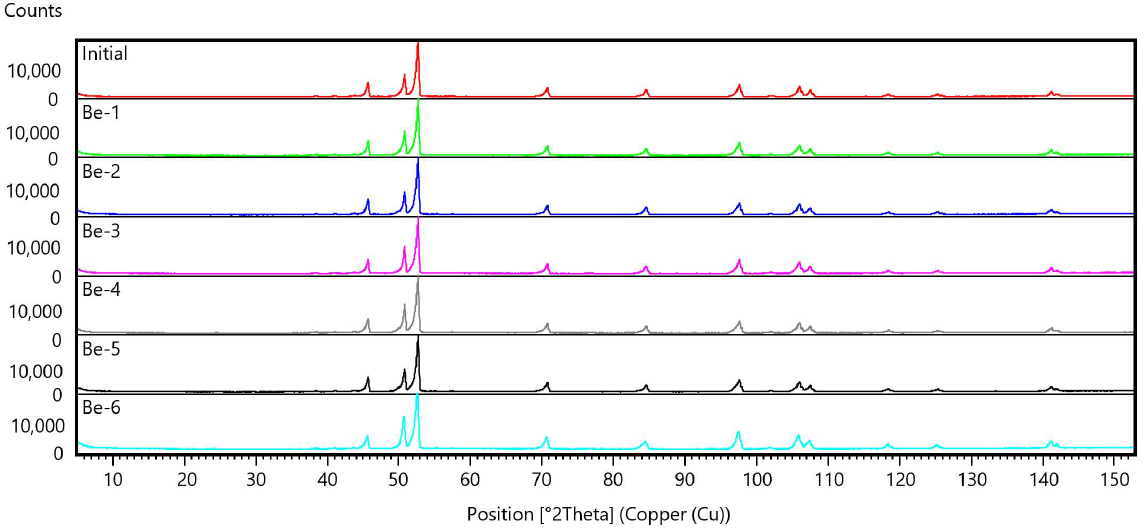
Figure 4. General view of the X-ray diffractograms of Be. Table 2. The results of the evaluation of the quantitative content by the method of corundum numbers in the automatic mode of the “HighScore” program.